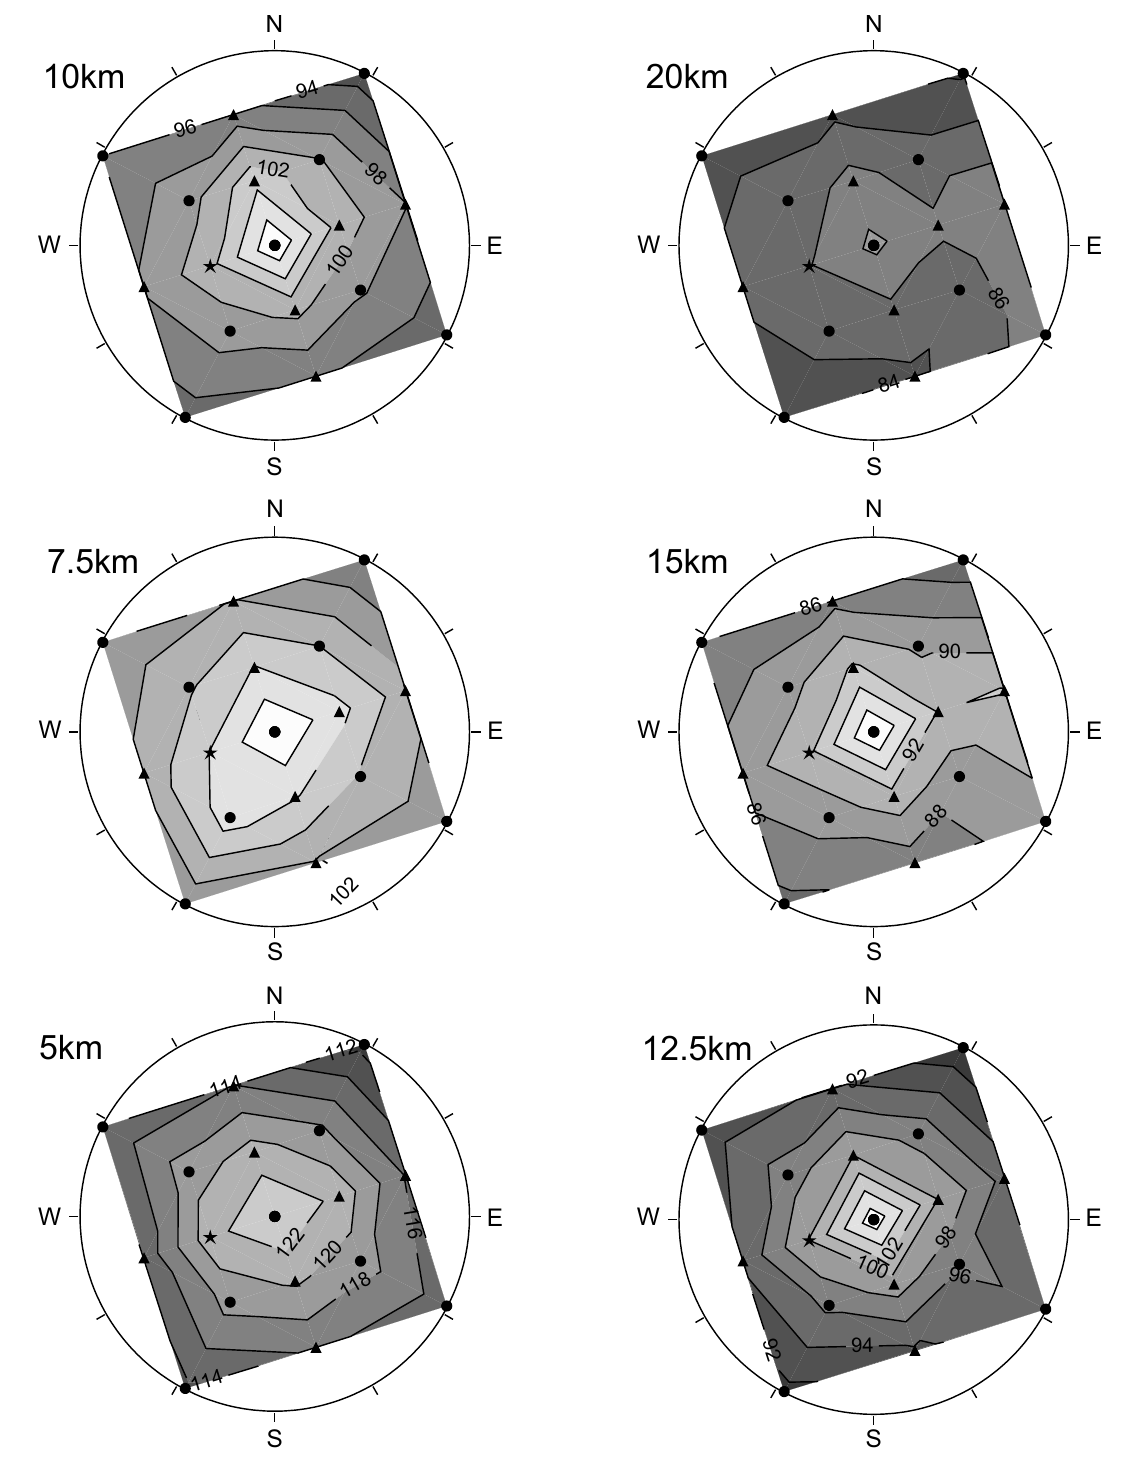
Figure 7. Average echo power maps derived from 8 weeks of special operation. The contours and labels give echo power in decibels. Symbols indicate the location of beams. Circles correspond to the 0, 6, and 12 ◦ zeniths; triangles give 4.2 and 8.5 ◦ zeniths. The star indicates the 4.2 ◦ zenith beam used to calculate aspect sensitivity for routine observations. The range is indicated in each